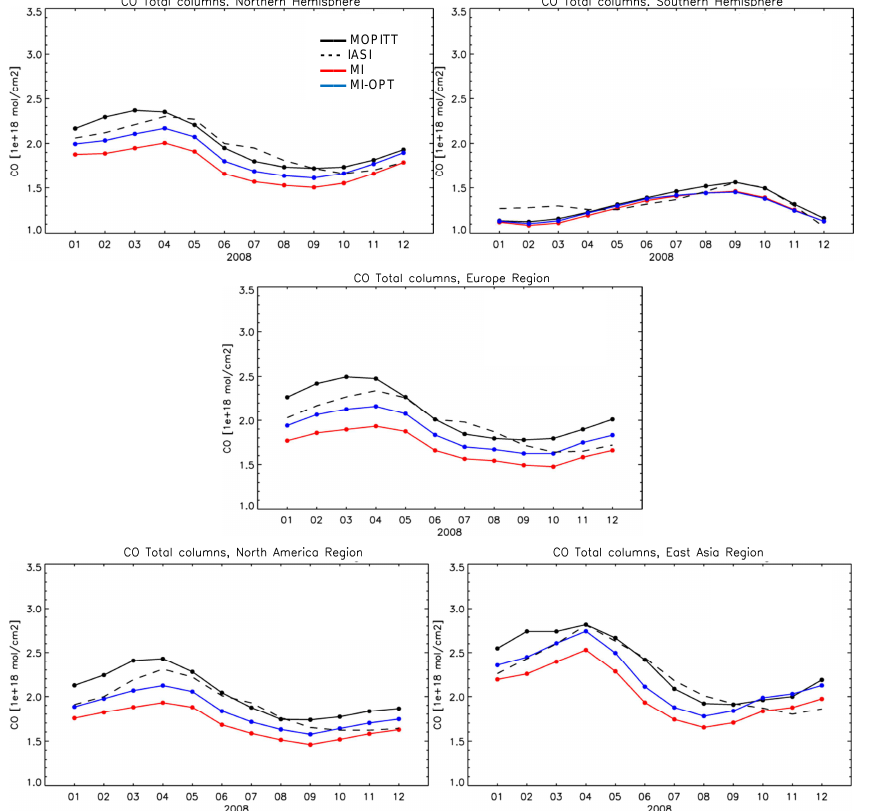
Figure 10. As in Fig. 7 but for the simulations MI (red) and MI-OPT (dark blue).